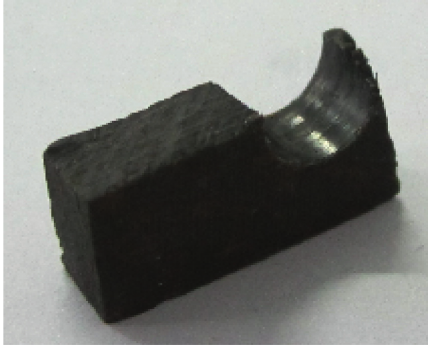
Figure 25: Observation sample of the hole wall.